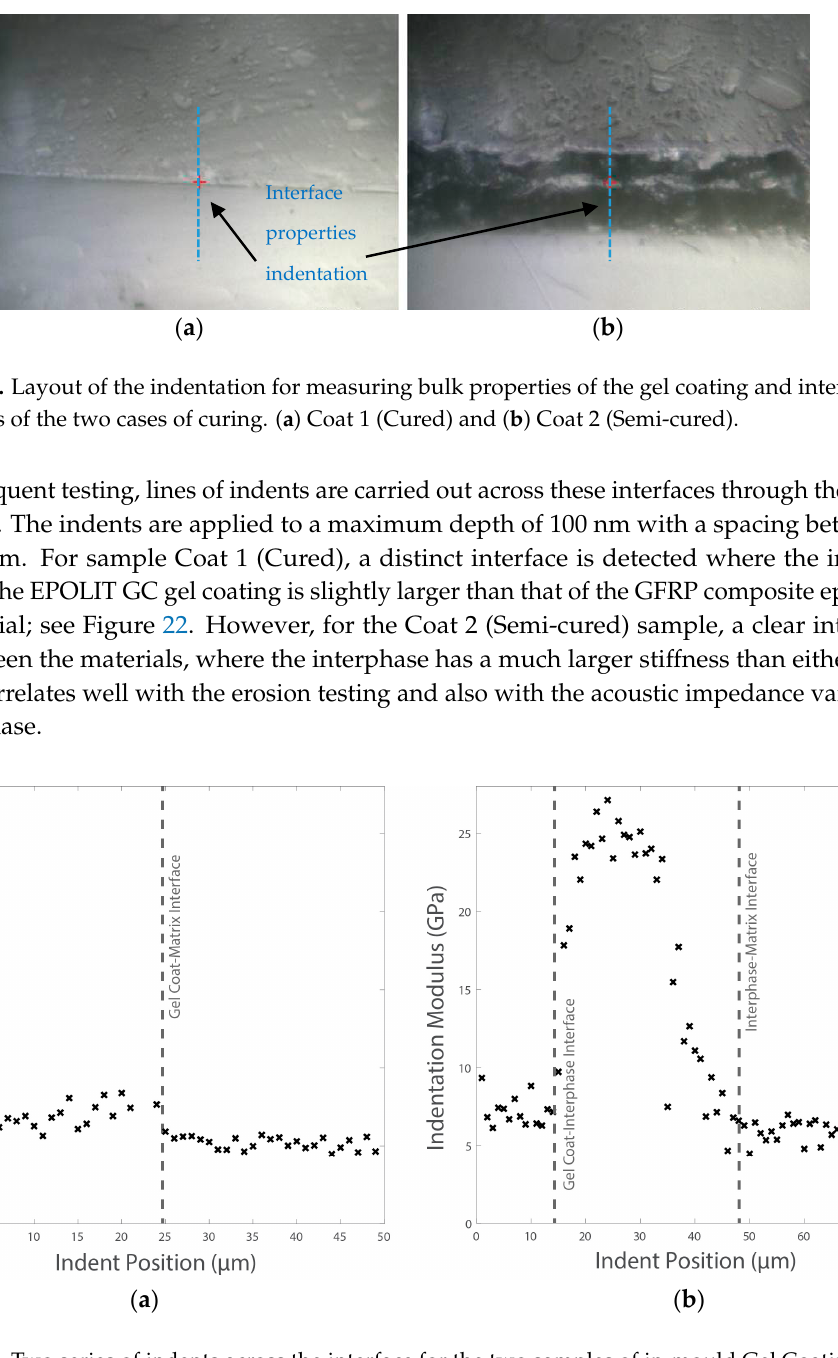
( b ) Figure 20. ( a ) Microscopy samples for interphase chemical adhesion: Coat 1, (Cured) and ( b ) Coat 2, (Semi-cured). Upper images magnification 100×, lower images are 400×). Table 2. Bulk properties obtained from gel coating configuration nanoindentation testing.